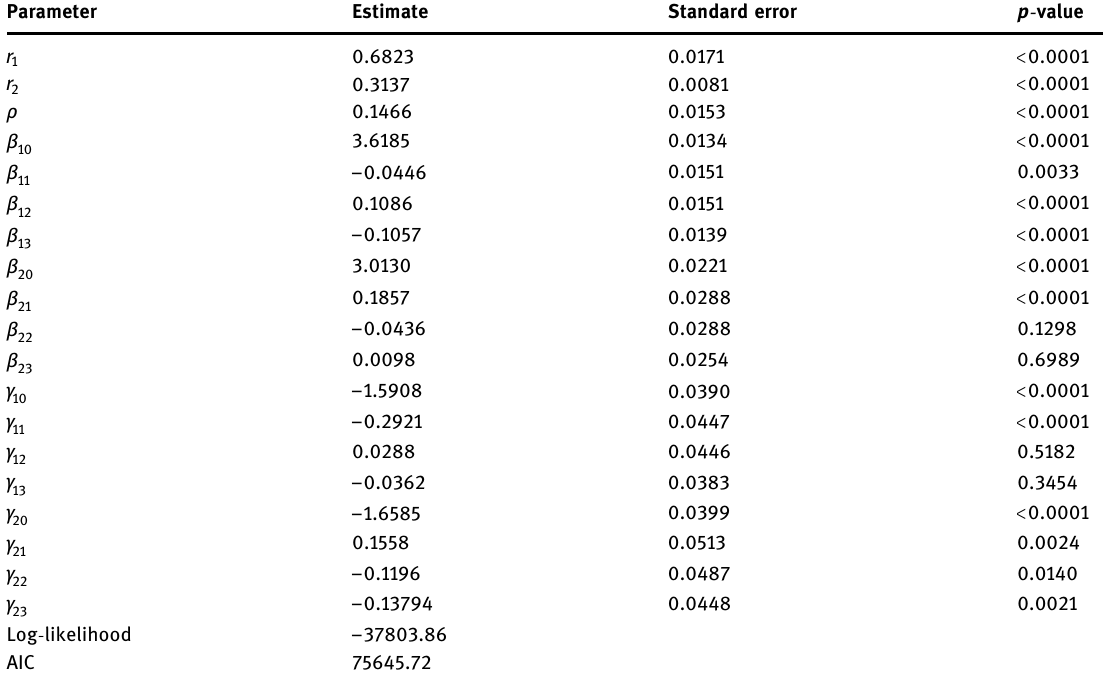
Table 6: Parameter estimates for